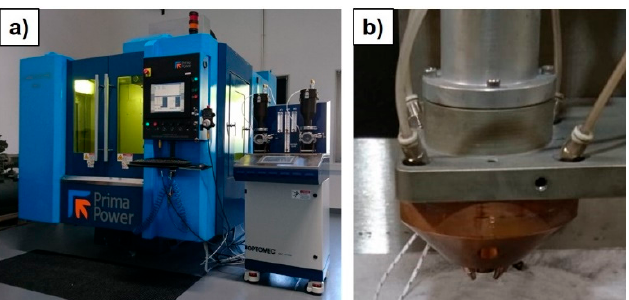
Figure 2. ( a ) Lasedyne 430 machine; ( b ) multi-nozzle Optomec ® deposition head.